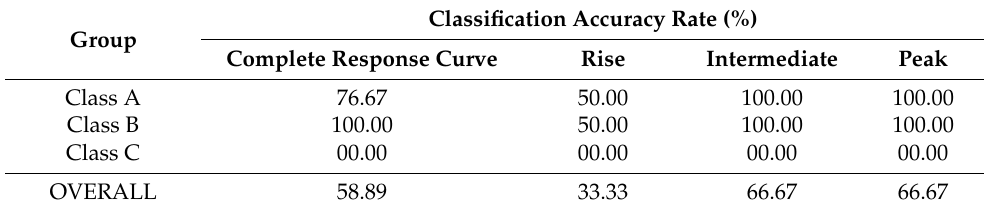
Table 11. Classification accuracy rate results with ANN application and validation